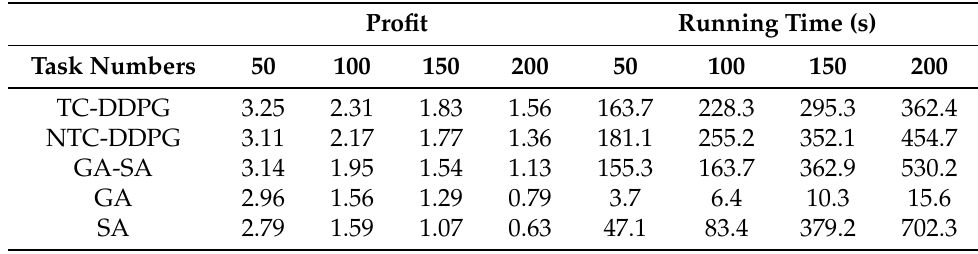
Table 5. Algorithm performance